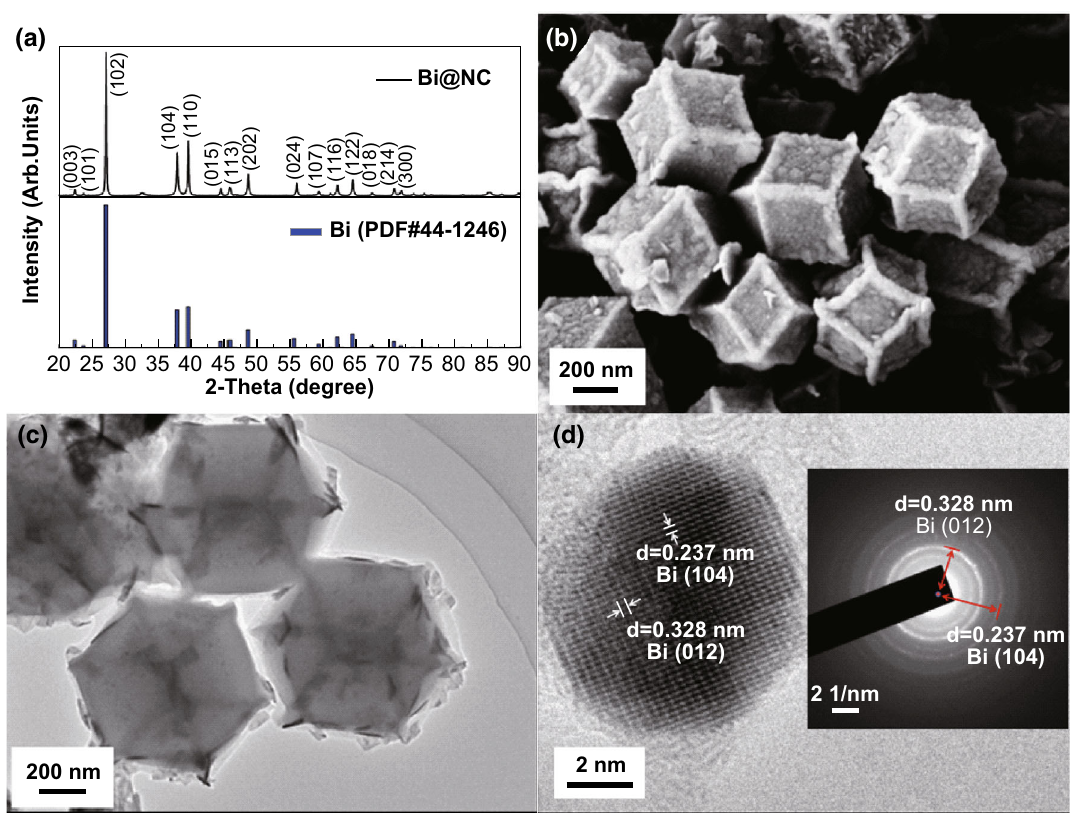
Fig. 5 a XRD pattern, b SEM, c TEM, HRTEM, and d SAED images of